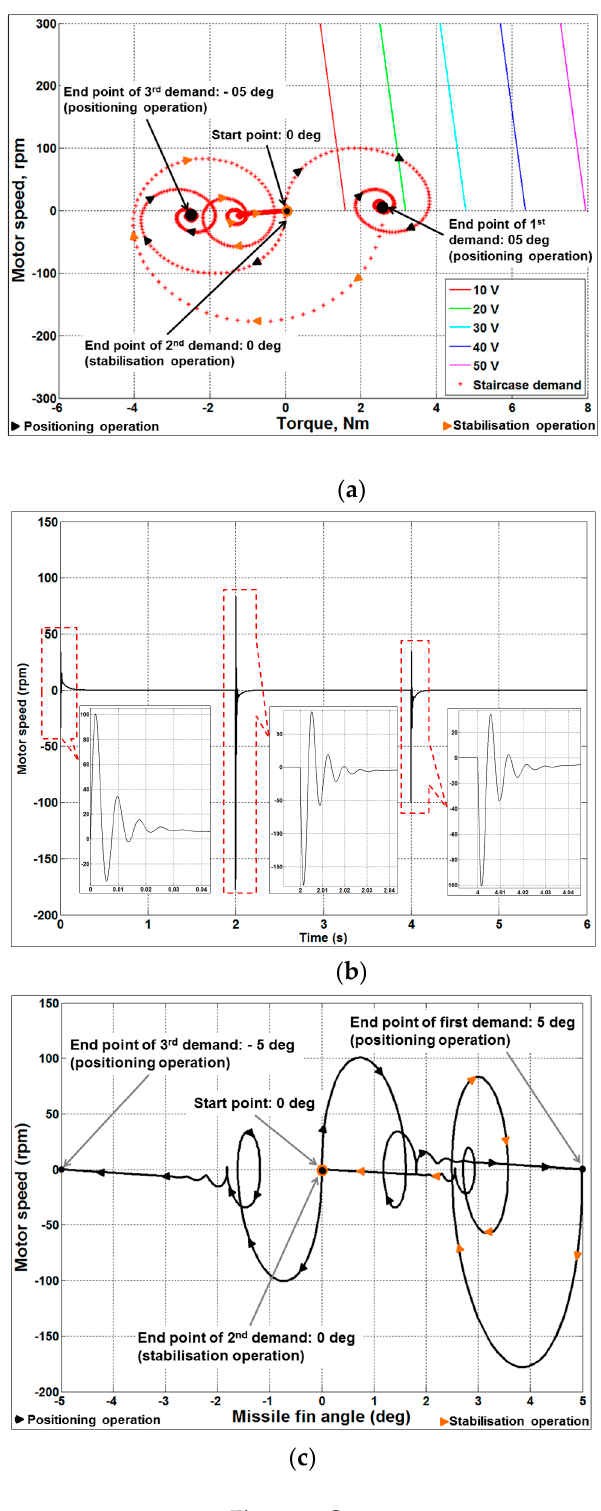
Figure 9. Cont. Figure 9.